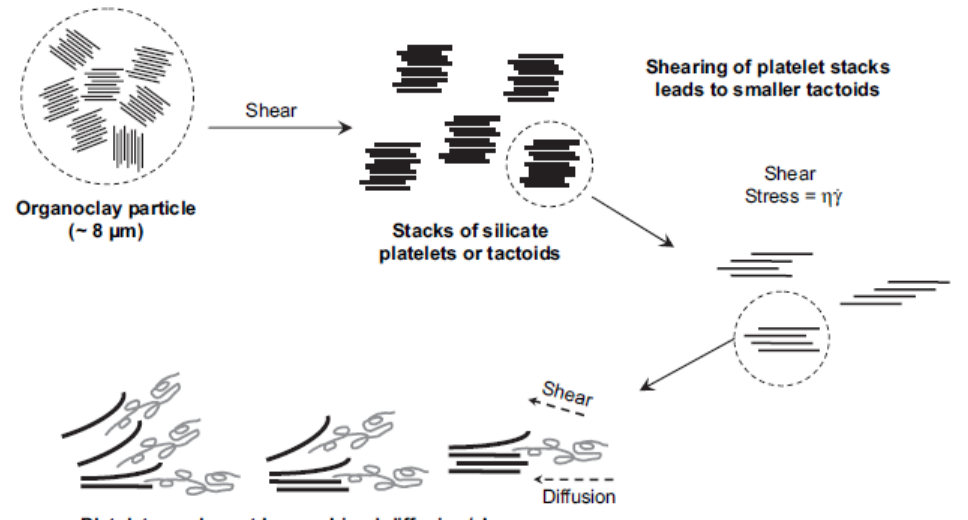
Figure 3. Mechanism of organoclay dispersion and exfoliation during melt processing